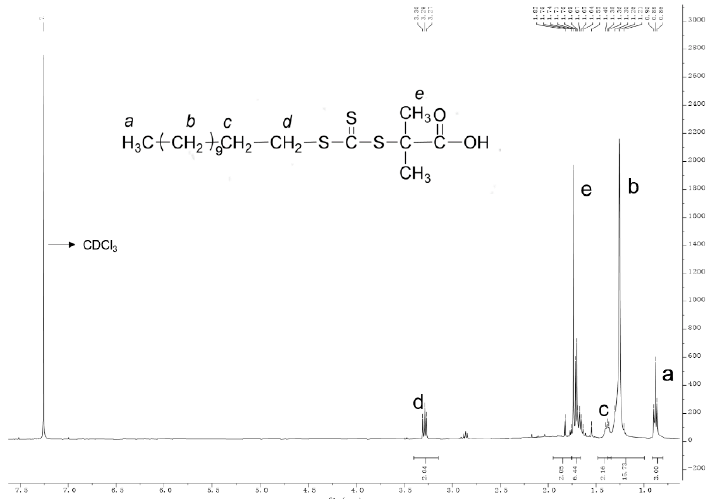
Figure 2. The 1 H NMR spectrum of chain transfer agent,